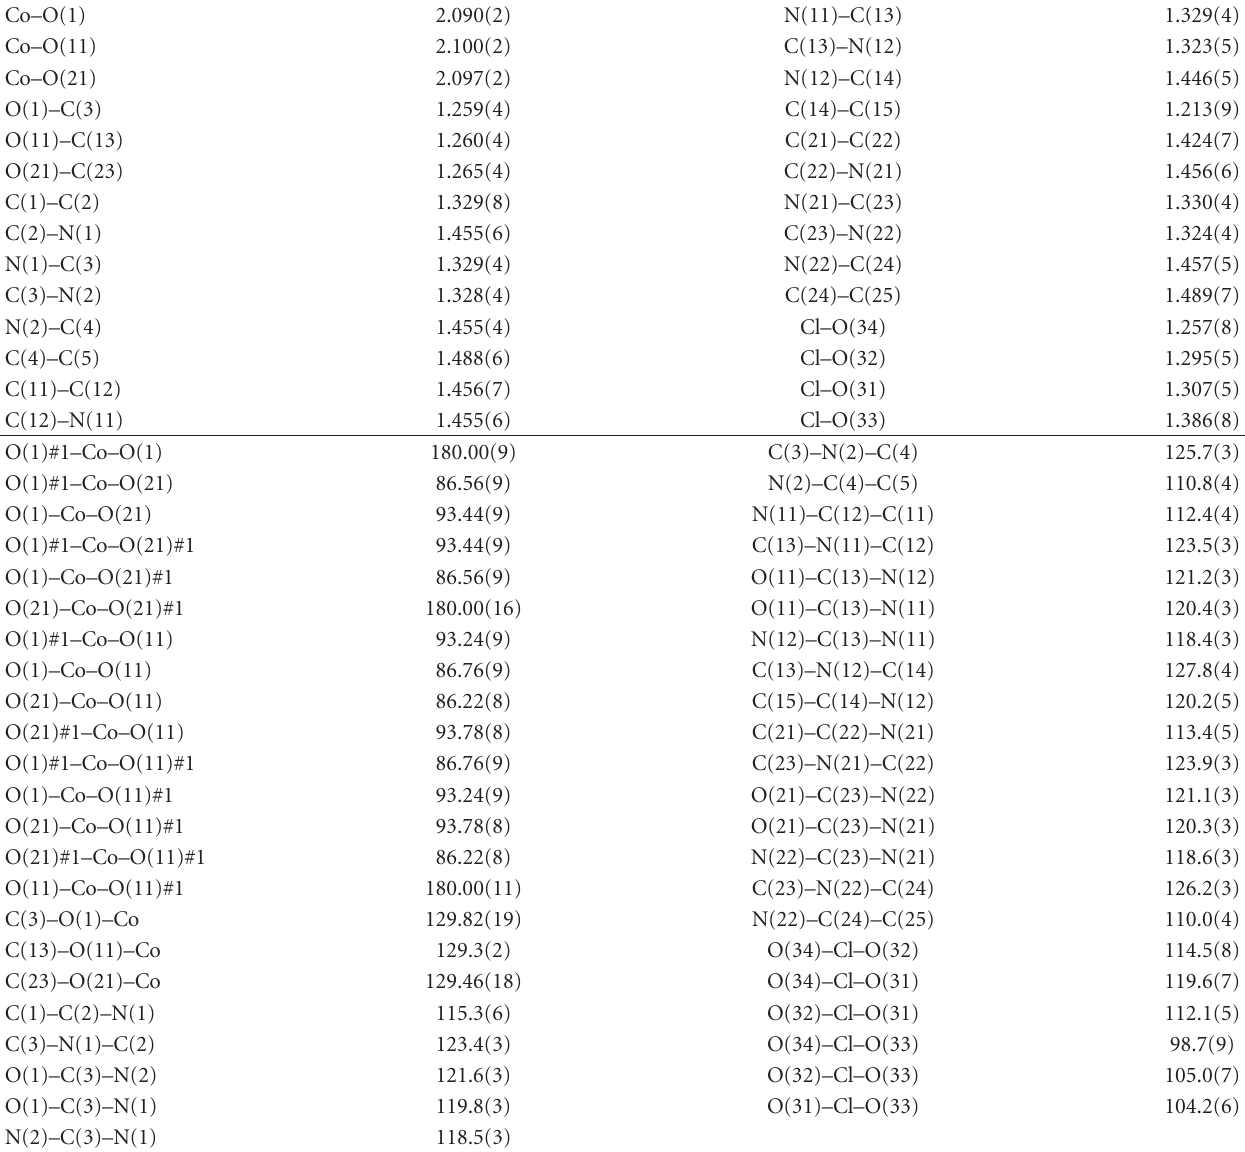
Table 3: Selected bond lengths (˚A) and angles ( ◦ ) for 2